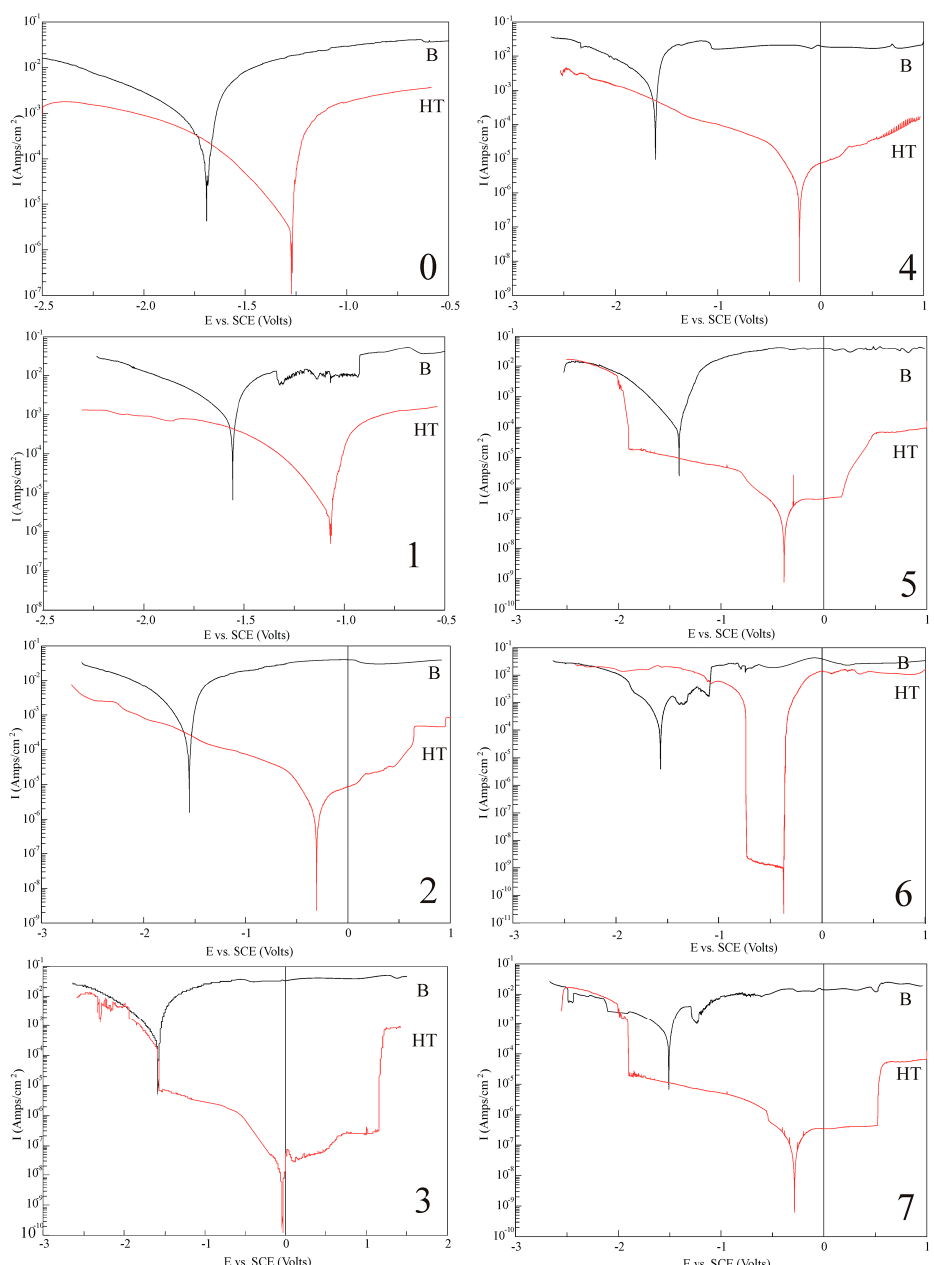
Figure 6. Corrosion resistance data based on potentiodynamic curves of analyzed base (black) and hydrothermally treated surfaces (red) marked in accordance to sample composition. ( 0 ): Mg pure— Reference sample; ( 1 ): Mg4Y5.5Dy0.5Zr; ( 2 ): Mg4Y5.5Dy0.5Zr + 5%BG; ( 3 ): Mg4Y5.5Dy0.5Zr + 5%BG + 1%Ag; ( 4 ): Mg1Zn1Mn0.3Zr; ( 5 ): Mg1Zn1Mn0.3Zr + 5%HA; ( 6 ): Mg1Zn1Mn0.3Zr + 5%HA + 1%Ag; ( 7 ): Mg1Zn1Mn0.3Zr +